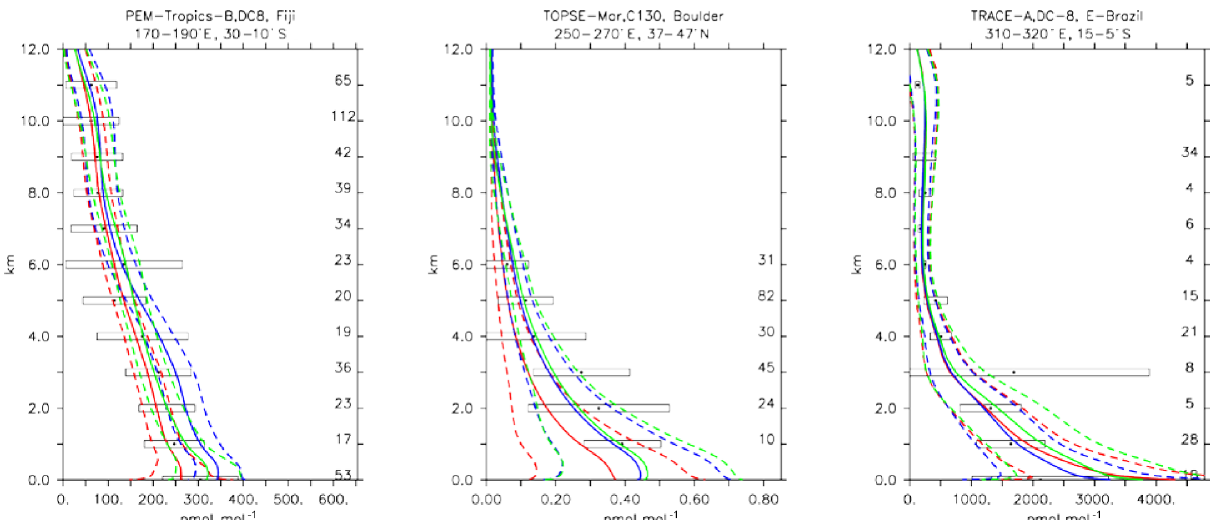
Figure 13. Comparison of simulated CH 2 O vertical profiles by using the CBA (red), MOC (blue) and MOZ (green) chemistry versions against aircraft data (black). Line styles and symbols have the same meaning as in Fig.